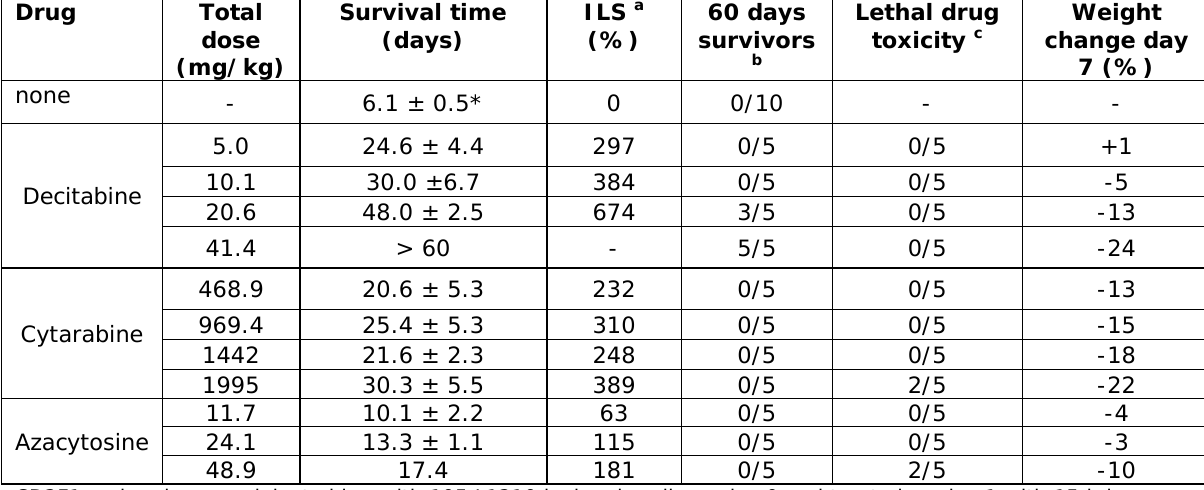
Table 4: Effect of Decitabine, Cytarabine and Azacytosine against L1210 Mouse